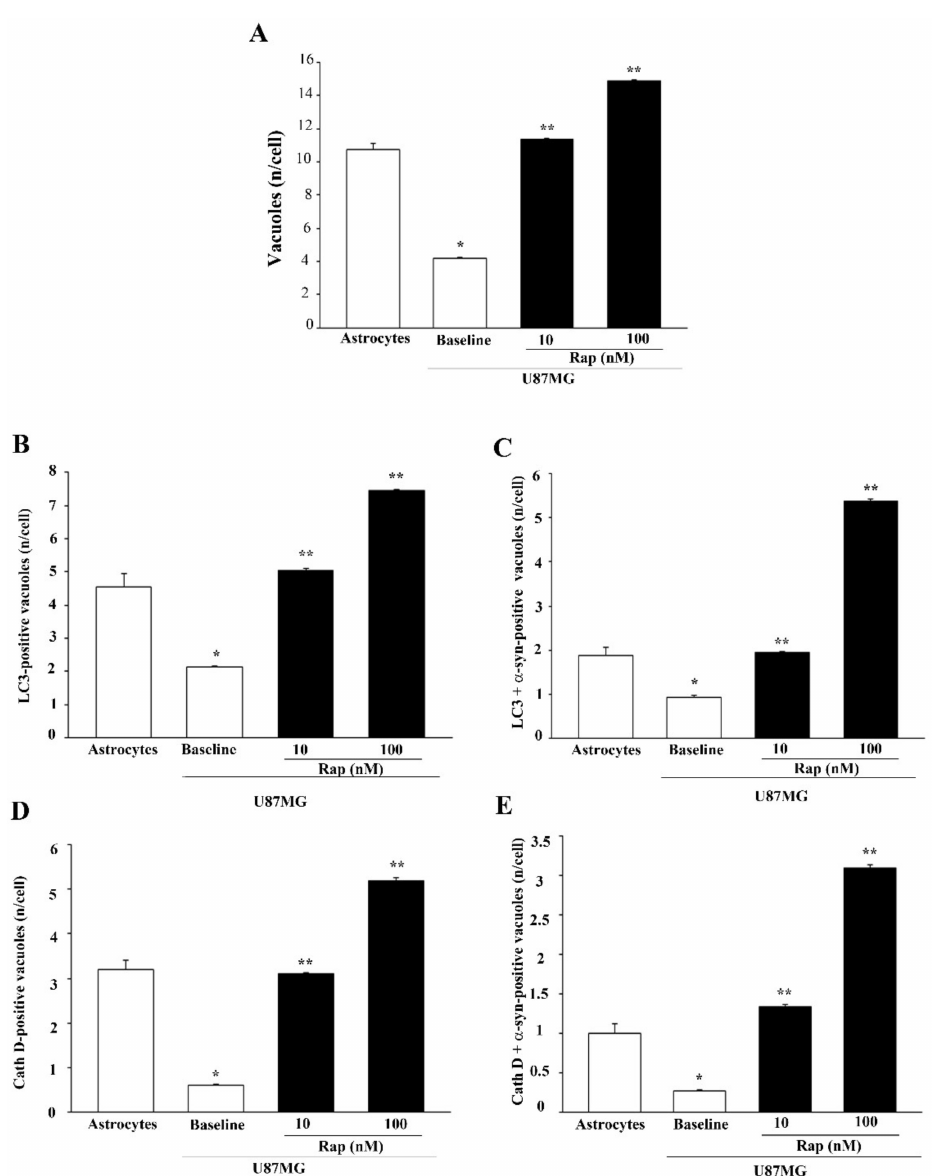
Figure 15. Quantification of α -syn + LC3- or α -syn + cathepsin D-positive vacuoles within astrocytes and U87MG cells in baseline conditions and after rapamycin. Graphs report the total number of vacuoles per cell ( A ), the number of LC3-positive vacuoles per cell ( B ), the number of LC3 + α - syn-positive vacuoles per cell ( C ), the number of cathepsin D-positive vacuoles per cell ( D ), and the number of cathepsin D + α -syn-positive vacuoles per cell ( E ). These data were obtained from astrocytes and U87MG cells in baseline conditions and following rapamycin exposure (Rap 10 nM and Rap 100 nM). Data are given as the mean ± SEM from n = 30 cells per experimental group obtained in N = 3 independent experiments. * p < 0.05 compared with astrocytes; ** p < 0.05 compared with